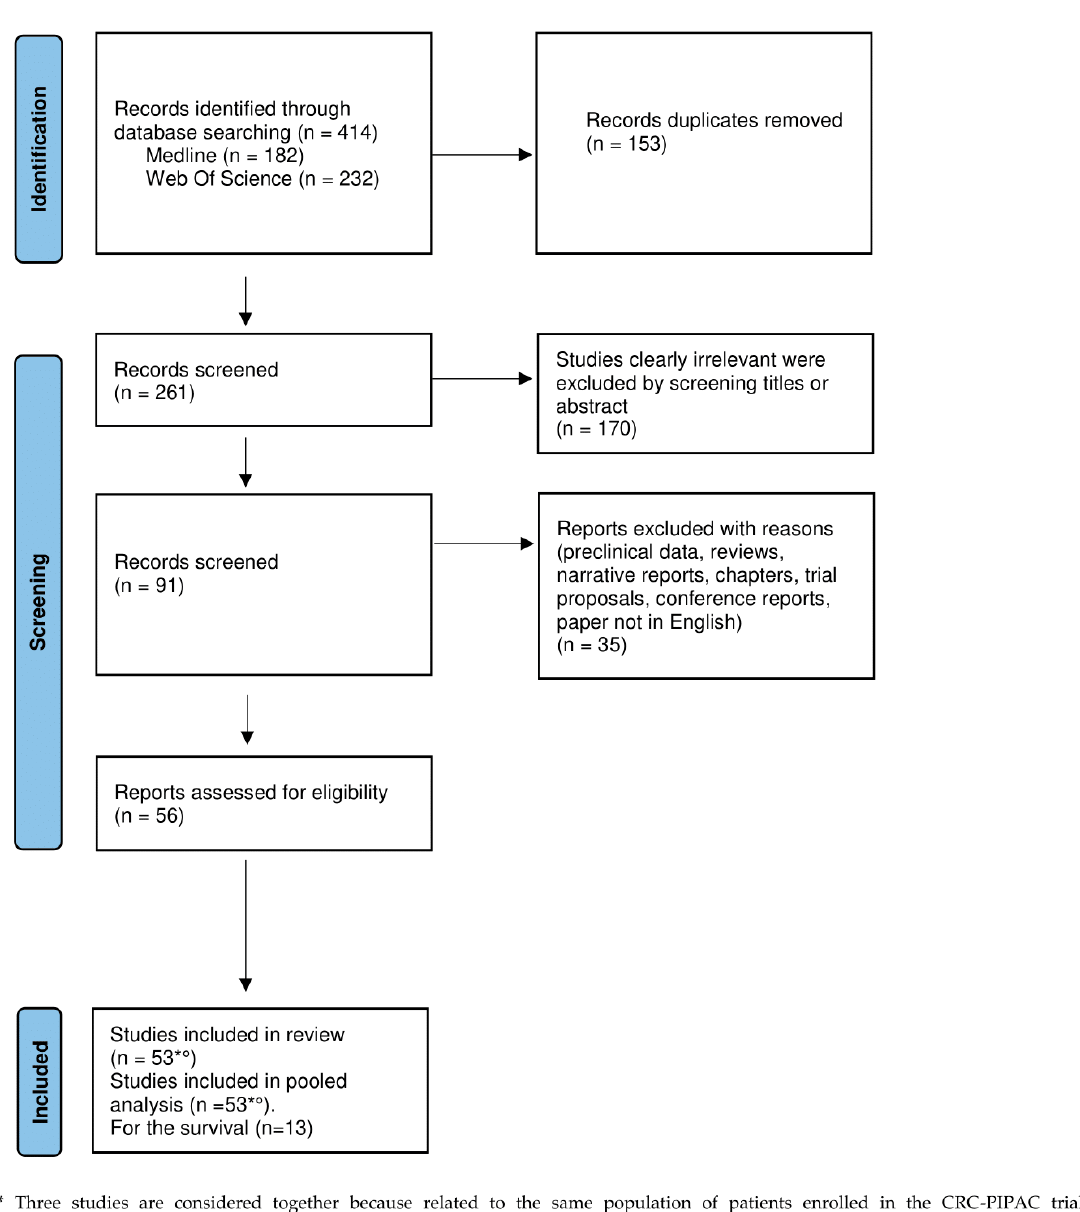
Figure 1. Study selection process (PRISMA flow diagram).